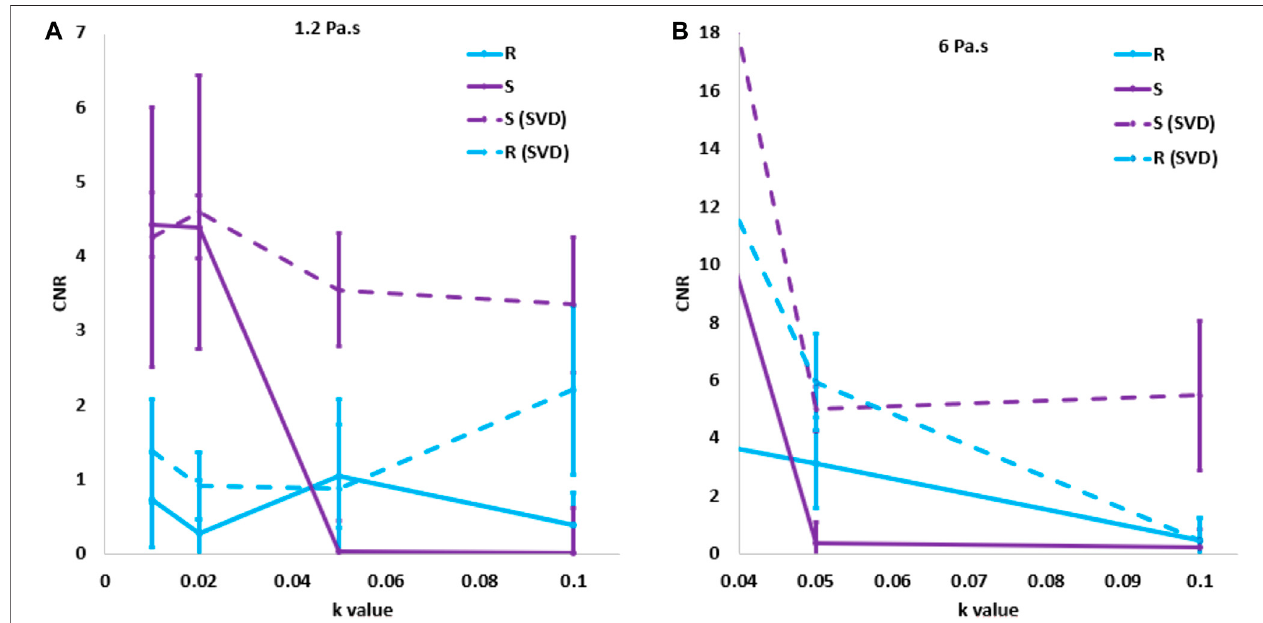
FIGURE 8 | Comparison of the contrast-to-noise ratio as a function of the noise level for the highest and lowest degrees of viscosity before and after apply the singular value decomposition fi lter.